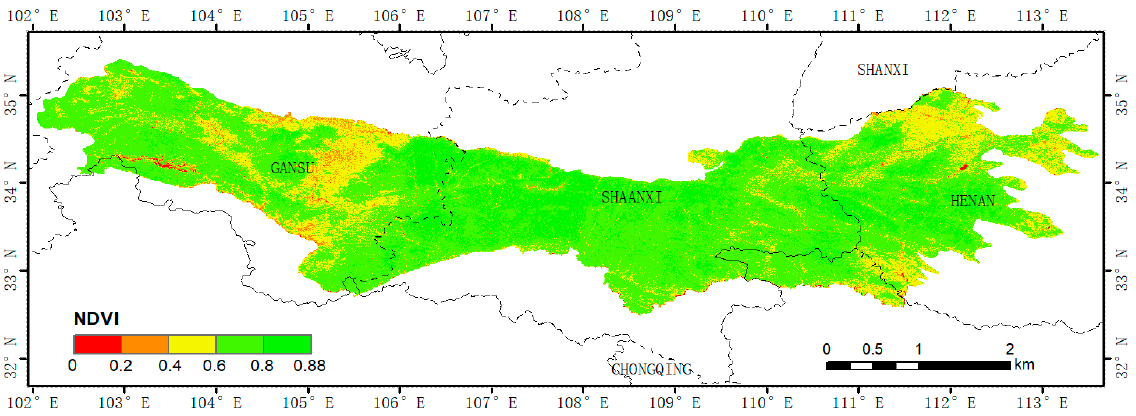
Figure 4. Spatial distribution of NDVI in Qinling Mountains during 1987–2018. From the perspective of spatial change trends and pixel statistics (Figures 5 and